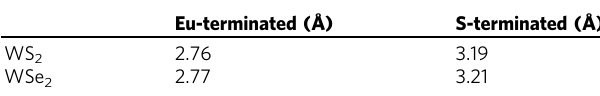
Table 1 Calculated equilibrium interlayer distances for polar surfaces of WS 2 and WSe 2 on